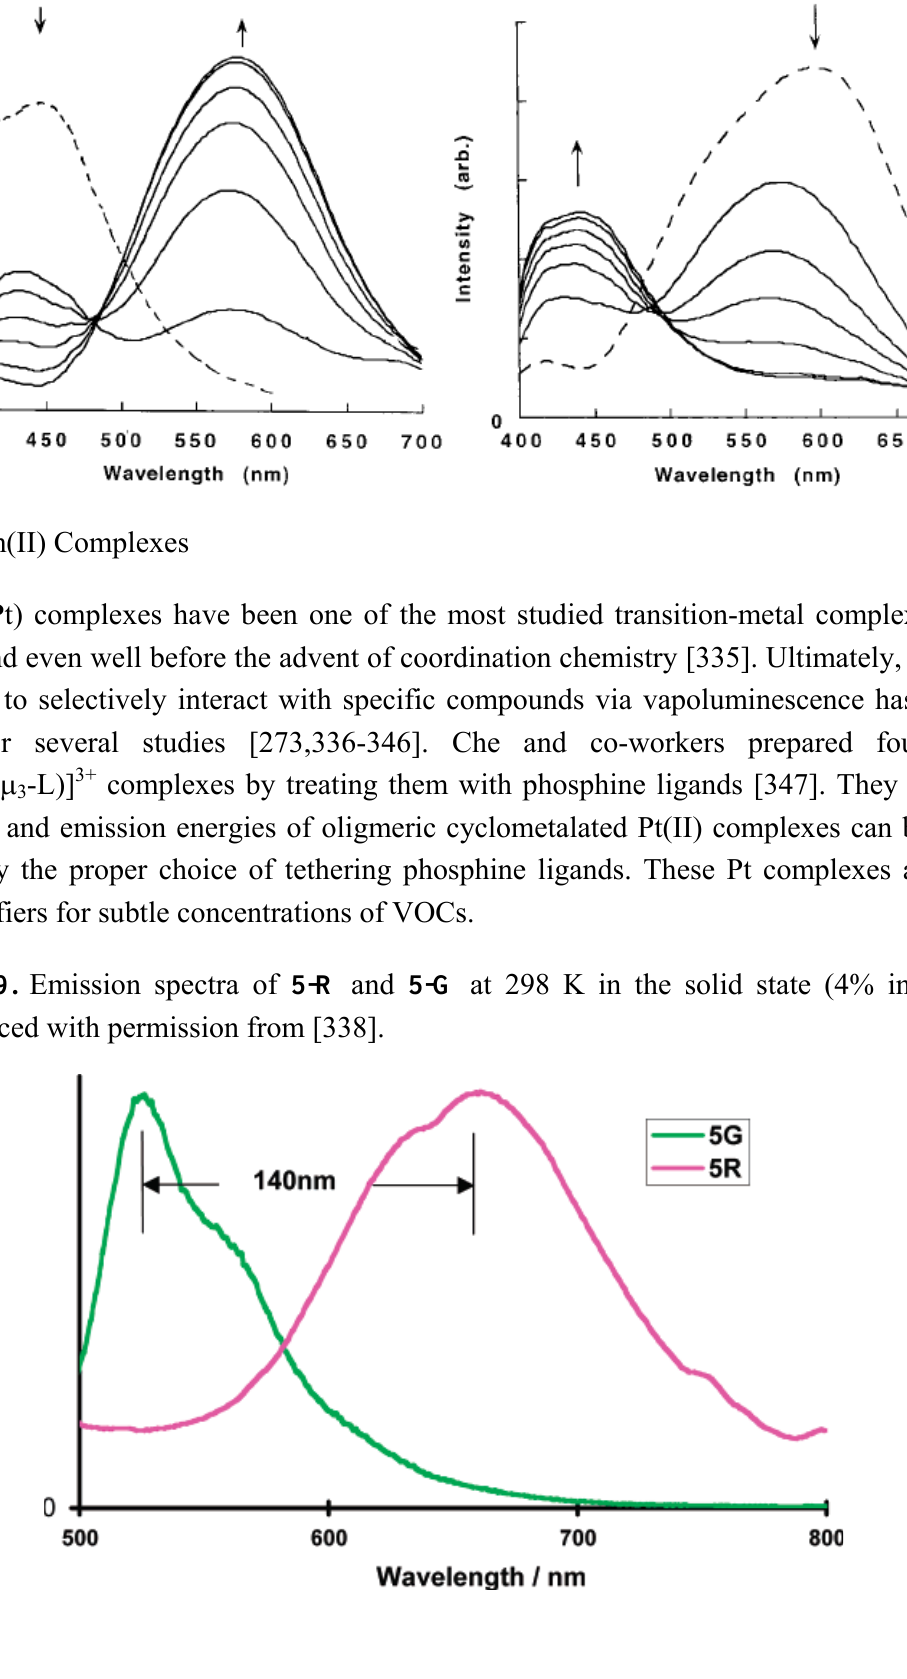
Figure 8. Emission spectral changes during the toluene induced [CuI(4-pic)] [CuI(4-pic)] transformation (left), and during the pentane induced [CuI(4-pic)] 4 [CuI(4-pic)] transformation (right). Reproduced with permission from [266]. ∞